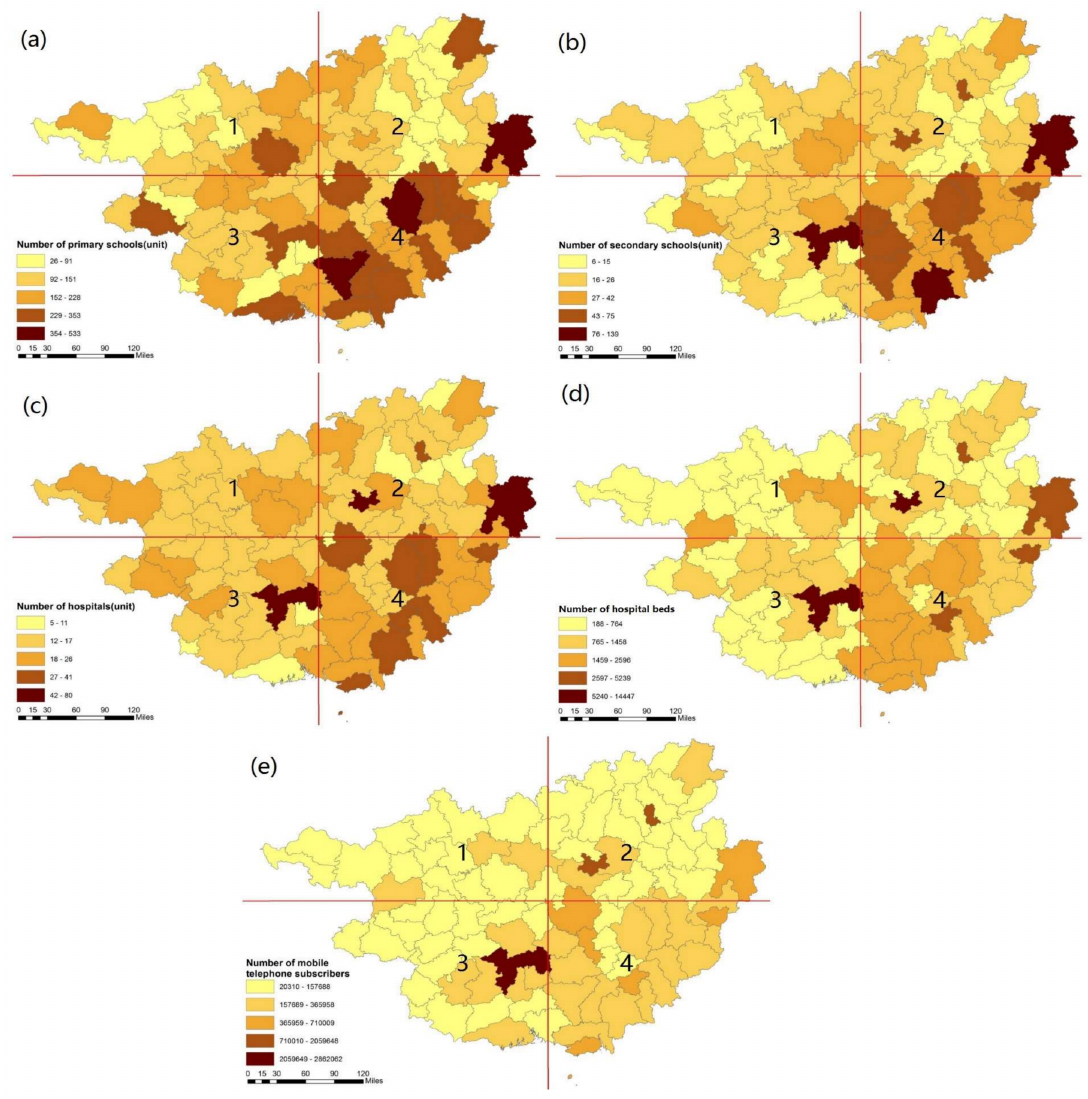
Figure 6. The spatial distribution of educational, infrastructural, and medical care indicators in Guangxi ( a – e